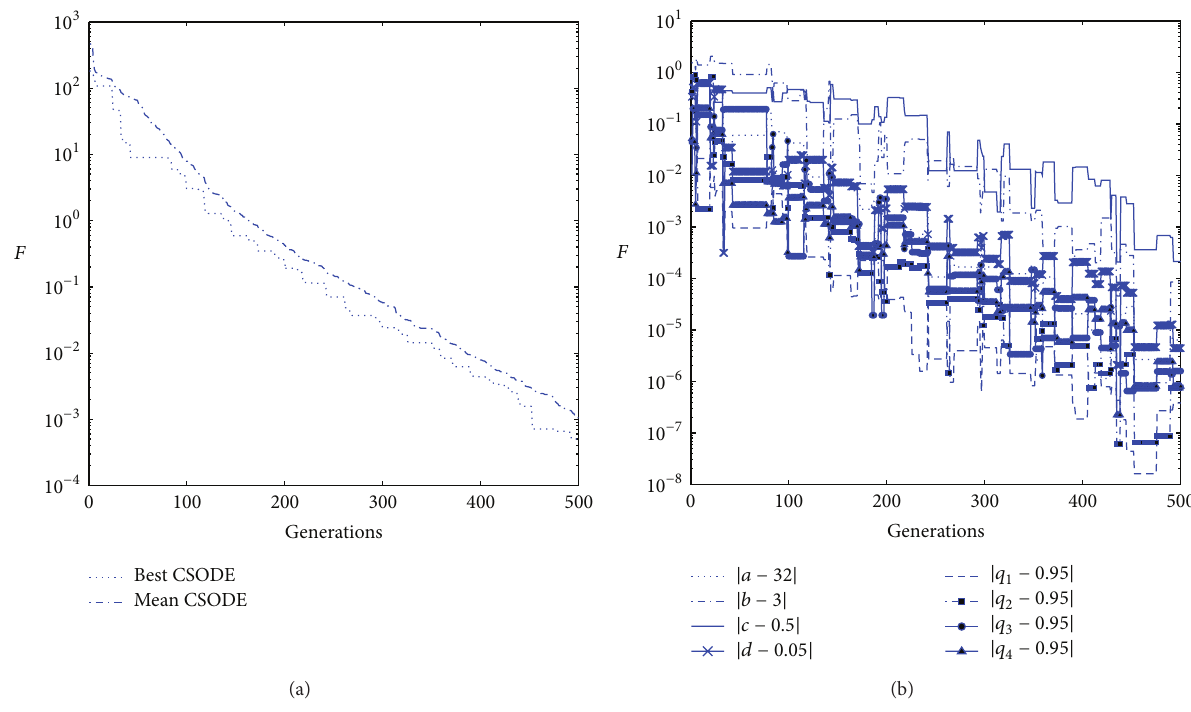
Figure 10: Evolution process for hyper fractional-order R¨ossler system.